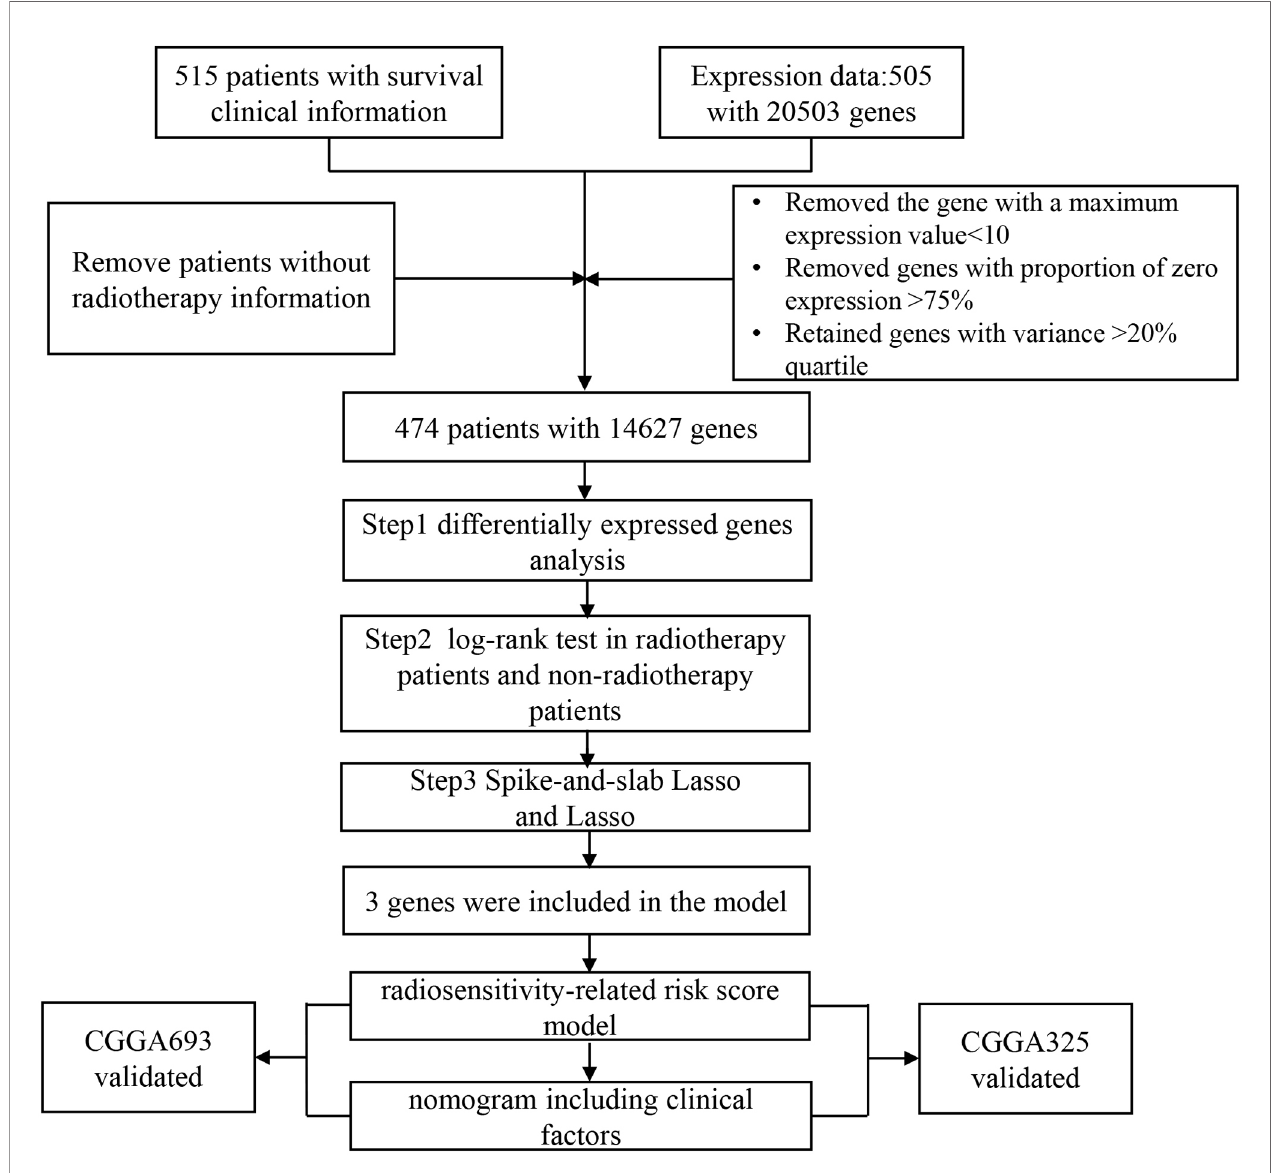
FIGURE 1 | The fl ow-chart of study design, patient selection and gene